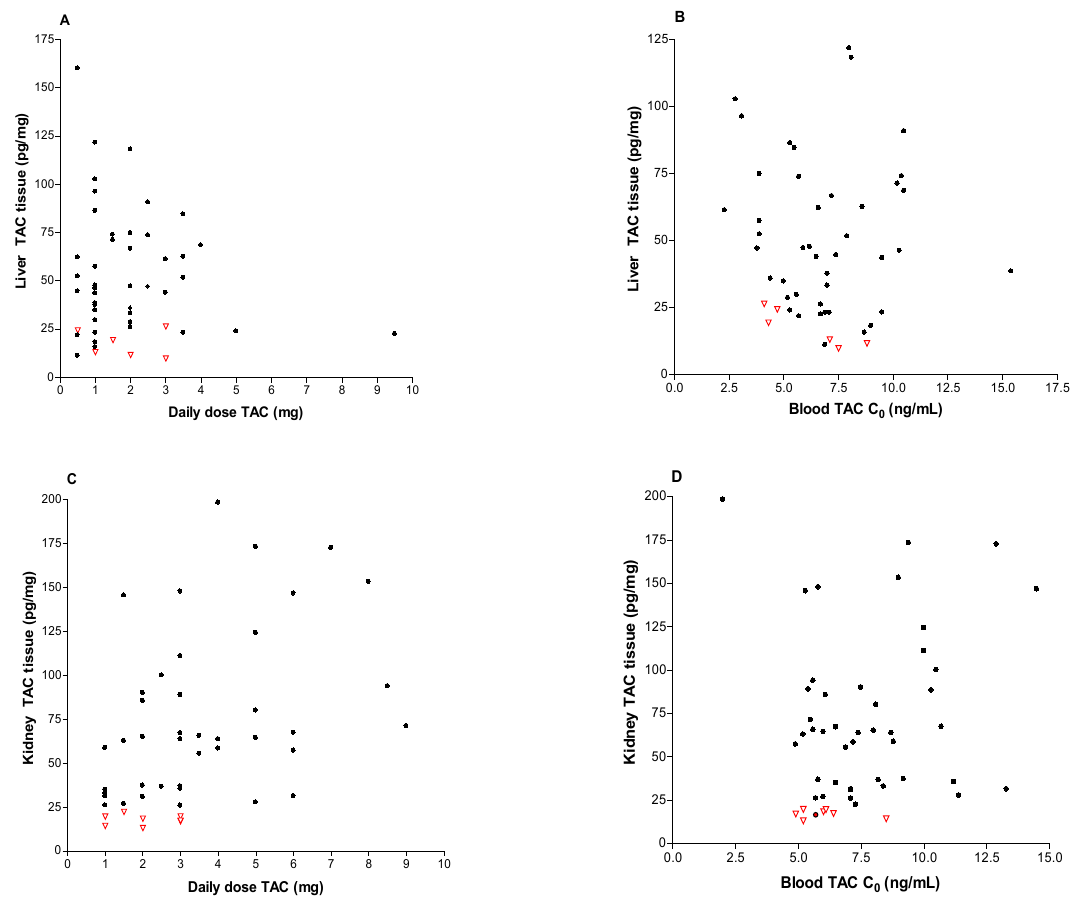
Figure 2. Correlations between the following: ( A ) liver TAC tissue concentrations and daily dose of Prograf (r = 0.014, p = 0.4244); ( B ) liver TAC tissue concentrations and blood TAC concentration (r = 0.021, p = 0.1519); ( C ) kidney TAC tissue concentrations and daily dose of Prograf (r = 0.073, p = 0.4577); and ( D ) kidney TAC tissue concentrations and blood TAC concentration (r = 0.052, p = 0.3918). Red “empty triangle” means recipients with moderate/severe rejection. Figures 3 and 4 shows kidney and liver tissue and blood TAC levels determined in 100 transplant patients.